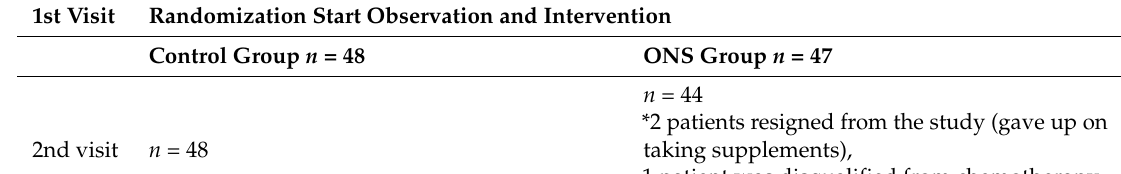
Table A1. The reasons for dropout of the study and causes of early termination of chemotherapy due to severe